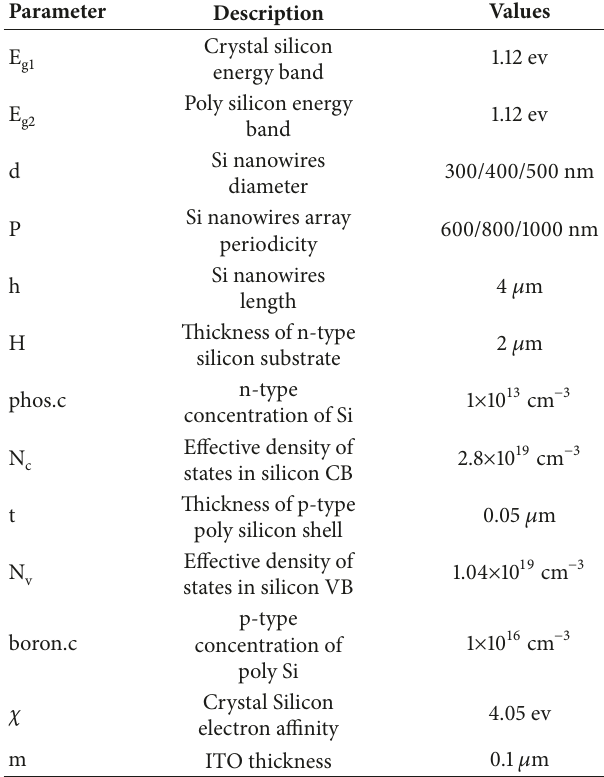
Table 1: List of modeling parameters and defect